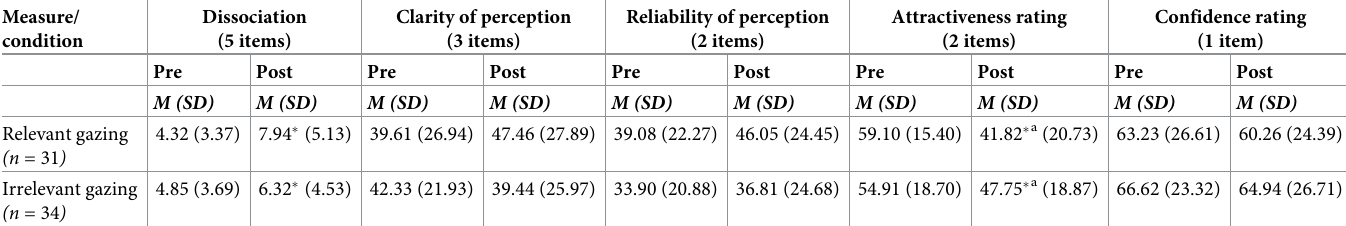
Table 1. Dissociation, perceptual uncertainty and attractiveness rating.